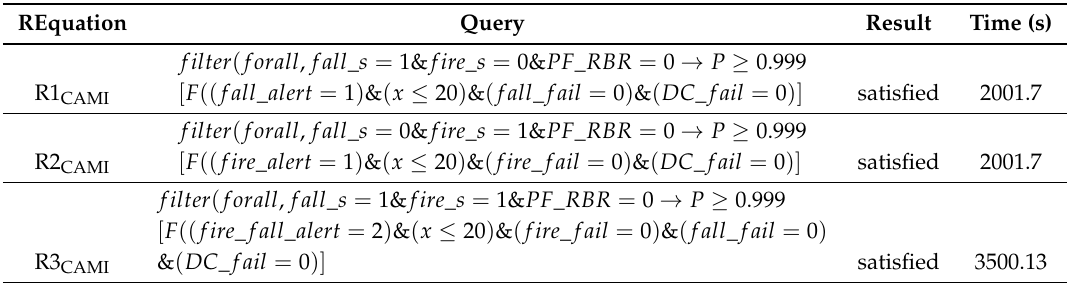
Table 4. PRISM verification